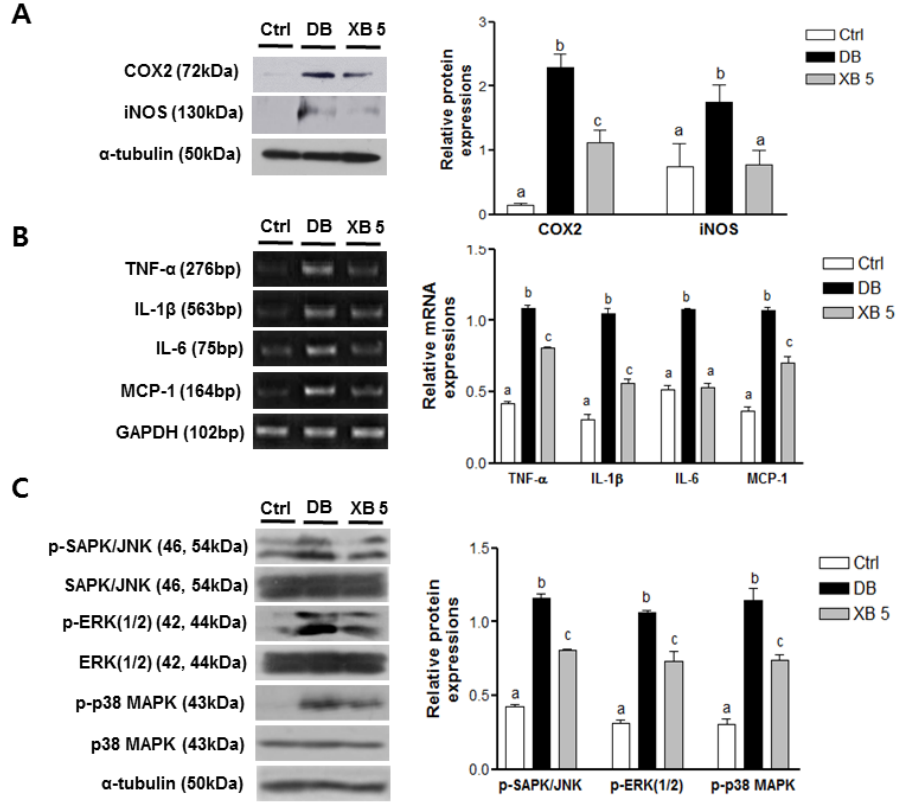
Figure 7. Levels of pro ‐ inflammatory markers and phosphorylated MAPKs in the liver. ( A ) Protein levels of COX2 and iNOS were detected in liver tissues by Western blotting; ( B ) RT ‐ PCR was used to detect mRNA levels of TNF ‐α (Tnf), IL ‐ 1 β (Il1b), IL ‐ 6 (Il6), and MCP ‐ 1 (Mcpt1) in liver tissues; ( C ) phosphorylation of MAPKs in liver tissues were analyzed by Western blotting. Representative blots are shown in the left panels. Band intensities were quantified by densitometry (right panels) and analyzed with one ‐ way ANOVA with Newman–Keuls post hoc test. GAPDH (Gapdh) and α‐ tubulin were used as loading controls. The values shown are the mean ± SEM. a,b,c For a given column, data not sharing a common superscript letter significantly differ ( p < 0.05; Ctrl, n = 11; DB, n = 10; XB 5, n = 10). Ctrl, non ‐ diabetic mice; DB, diabetic mice; XB 5, diabetic mice that received an AIN ‐ 93G diet with 5% of the total sucrose content replaced with xylobiose.